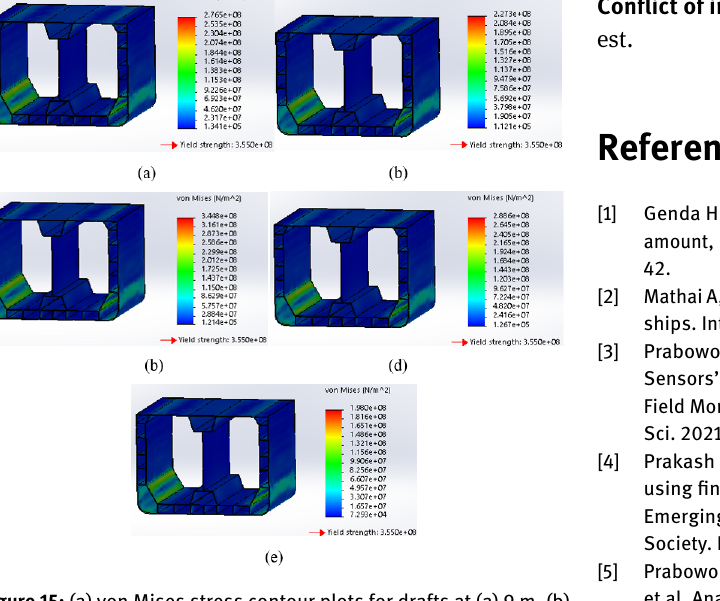
Figure 15: (a) von Mises stress contour plots for drafts at (a) 9 m, (b) 8 m, (c) 7 m, (d) 6 m, and (d) 5